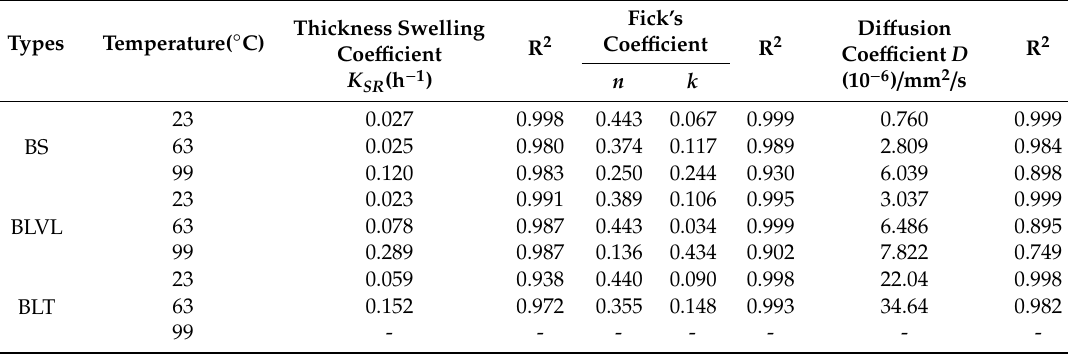
Table 1. Fitting results of water absorption parameters at different aging temperatures.